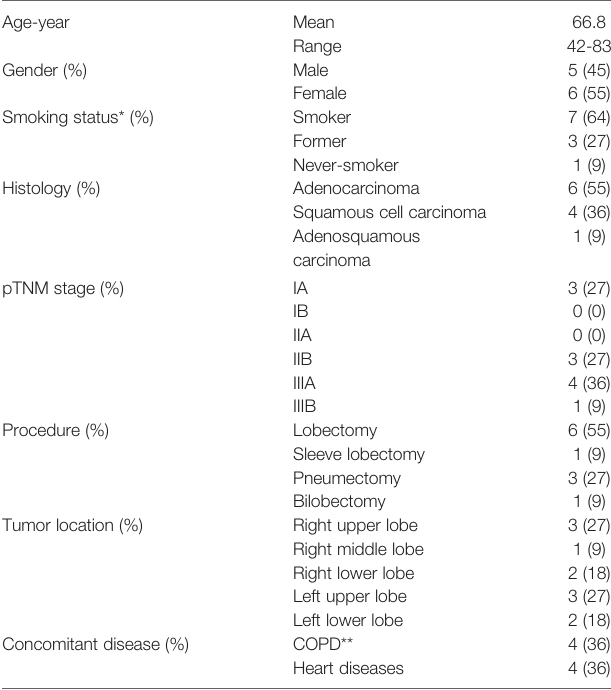
TABLE 1 | Characterization of the NSCLC patient cohort